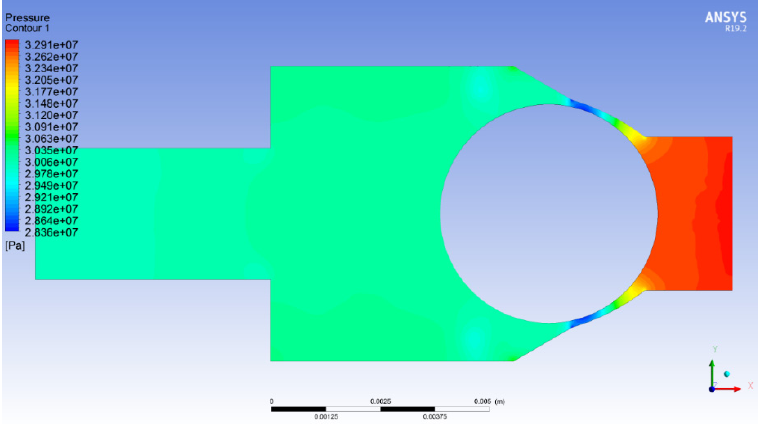
Figure 10. Pressure CFD: Spherical Seat Valve − x = 1.005 [mm], pdn = 2000 [bar] and pup = 2100 [bar]. Figures 11 and 12 are representing two different valves design with the pressure distribution by having the opening height x = 1.257 mm, pressure in upstream p up = 2100 bar and downstream p dn = 2000 bar. It can be seen that the pressure is no longer evenly distributed, and the differences between these two valve models are obvious. Apart from the low-pressure area, which is much smaller for the design of the spherical seat valve, the design of the conical seat valve has a larger area of low pressure compared to the simulation in Figure 9. The simulation also shows for the conical seat valve design a high- pressure area that can affect the valve’s integrity, leading to fatigue and cracks in the material [44].